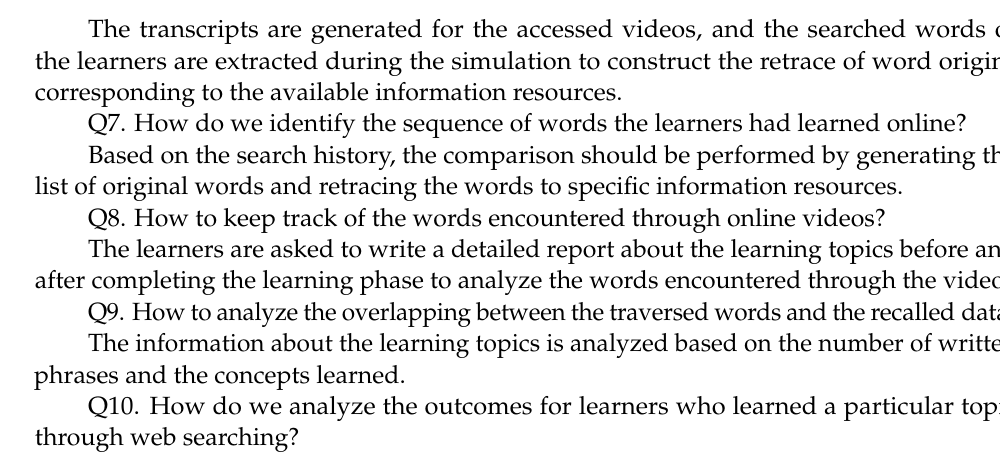
Figure 1. The architecture of the proposed resources processing model [7–14,34–38].